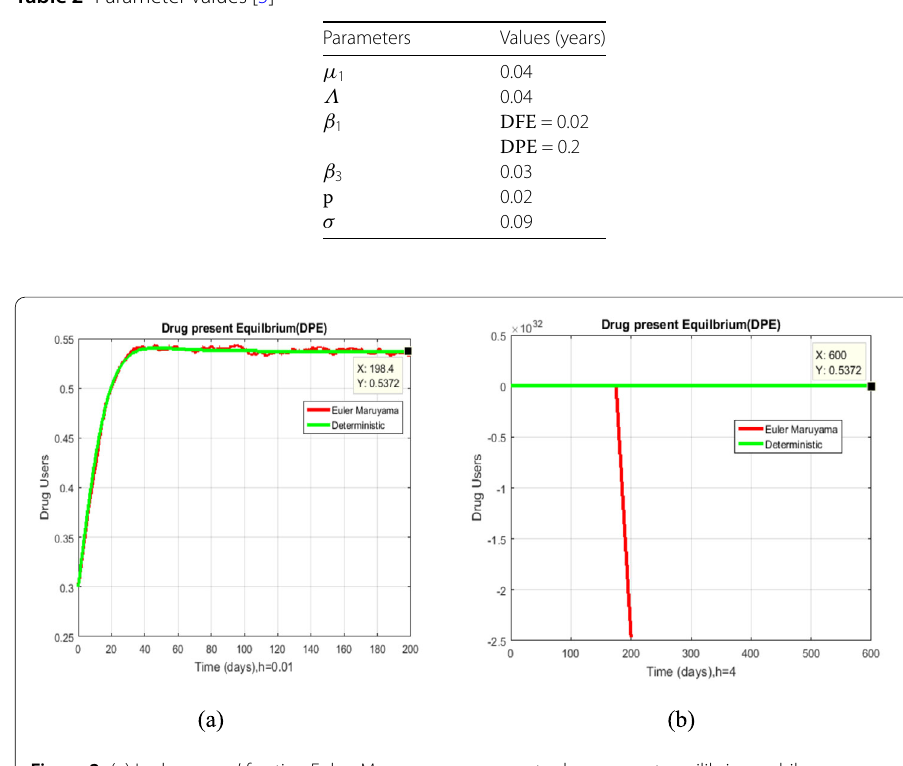
Table 2 Parameter values